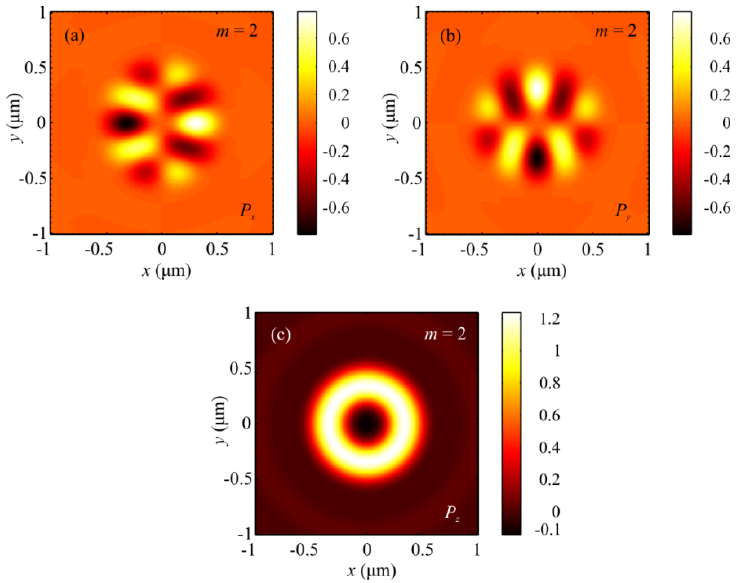
Figure 4. Patterns of the Poynting vector components ( a ) P x , ( b ) P y , and ( c ) P z in the focal plane when focusing a plane wave with the hybrid polarization of Equation (1) at m = 2.